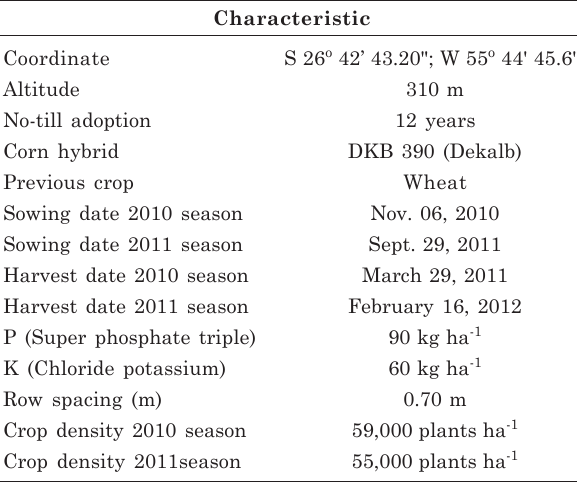
Figure 1. Day and cumulative rainfall experimental area during corn growing season in 2010 (a) and 2011 (b), in Alto Verá, Paraguay. Table 2. Characteristics of the experiments